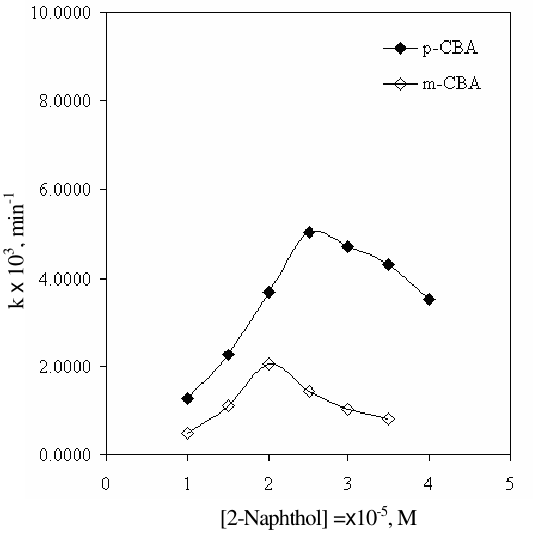
Figure 4. Effect of concentration of sensitizer [ m -CBA] = [ p -CBA] = 4 x 10 -5 M, light intensity= 11.8 x 10 -8 E sec-1, pH = 11.5, Temperature = 298